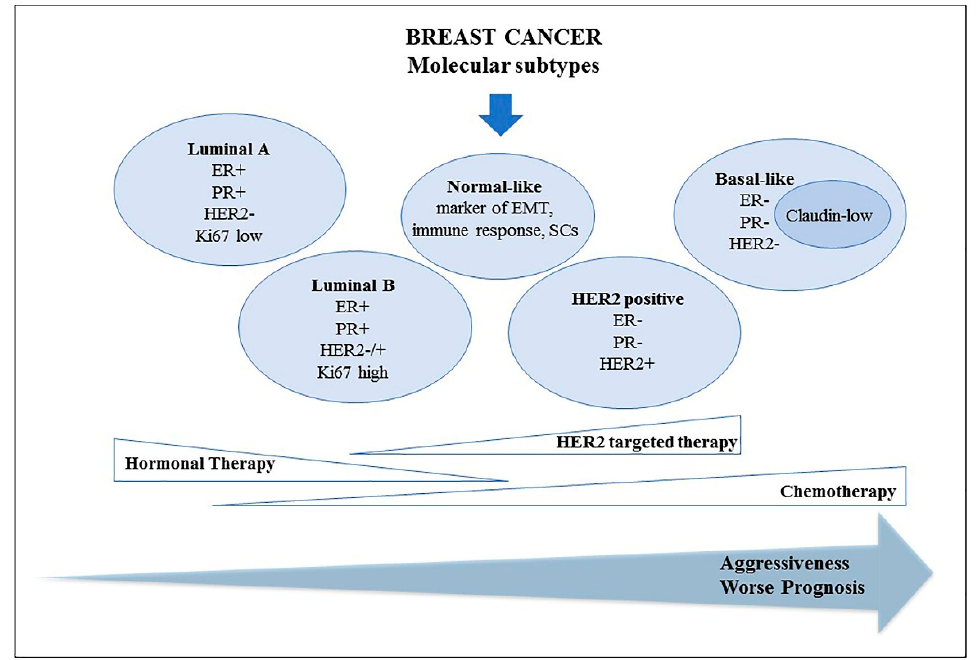
Figure 1. Classification of breast cancer molecular subtypes. Abbreviations: ER+, estrogen receptor positive; PR+, progesterone receptor positive; HER2+, human epithelial growth factor receptor 2 positive; EMT, epithelial-to-mesenchymal transition; SCs, stem cells.